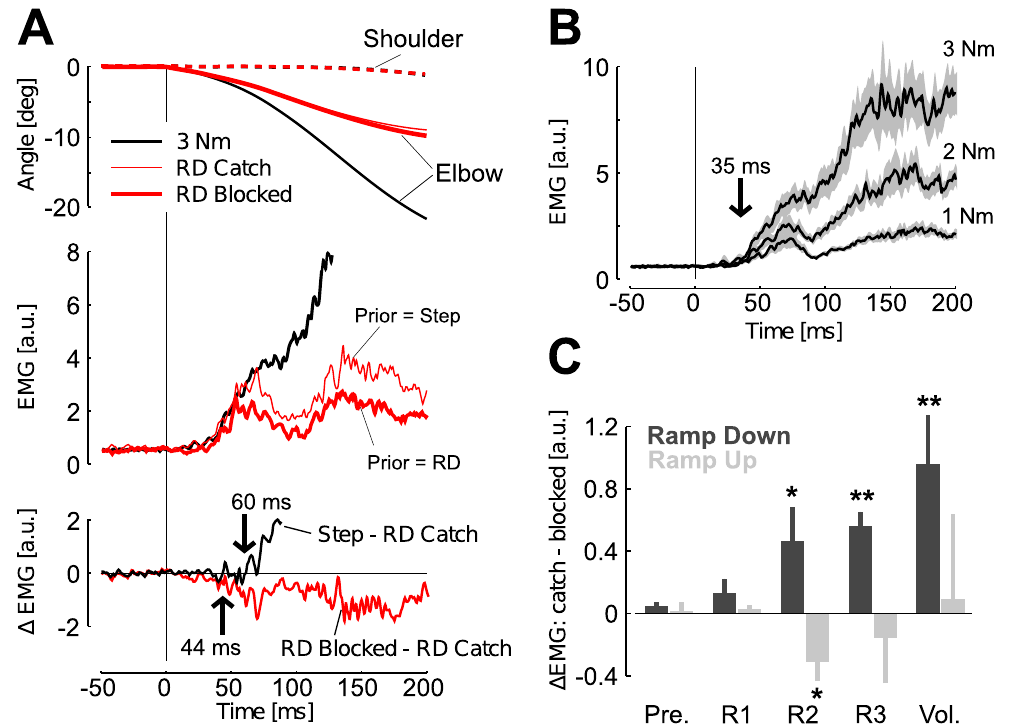
Figure 6. Experiment 1: Muscle responses. A: Top: Average shoulder (dashed) and elbow (solid) joint displacements following extension torques in three different cases, 3 Nm step torques (black), and ramp-down profiles in catch and blocked conditions (thin and thick red traces, respectively) averaged across subjects. Shoulder motion was identical across all conditions and the corresponding traces are superimposed. Middle: Perturbation- evoked response recorded from an elbow flexor (brachioradialis) with the same color code as in the top panel. Bottom: Difference between the 3 Nm step response and the ramp-down in the catch condition (black), and between ramp-down torques in the block and catch (red). Arrows indicate the onset of divergence from the 3 Nm evoked response. B: Response evoked by step-torque perturbations averaged across subjects. The shaded area represents the standard error. The vertical arrow depicts the latest divergence onset across all pair-wise comparisons. C: Changes in evoked response across the conditions where ramp-down (dark gray) or ramp-up (light gray) perturbations were presented in catch or blocked design. The grand average of Brachioradialis and Triceps Lateralis responses was considered for this analysis. Positive designates that the evoked activity decreased in the block